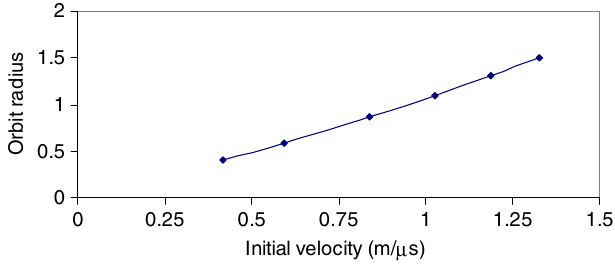
FIG. 9. Orbit radii as a function of initial electron velocity.